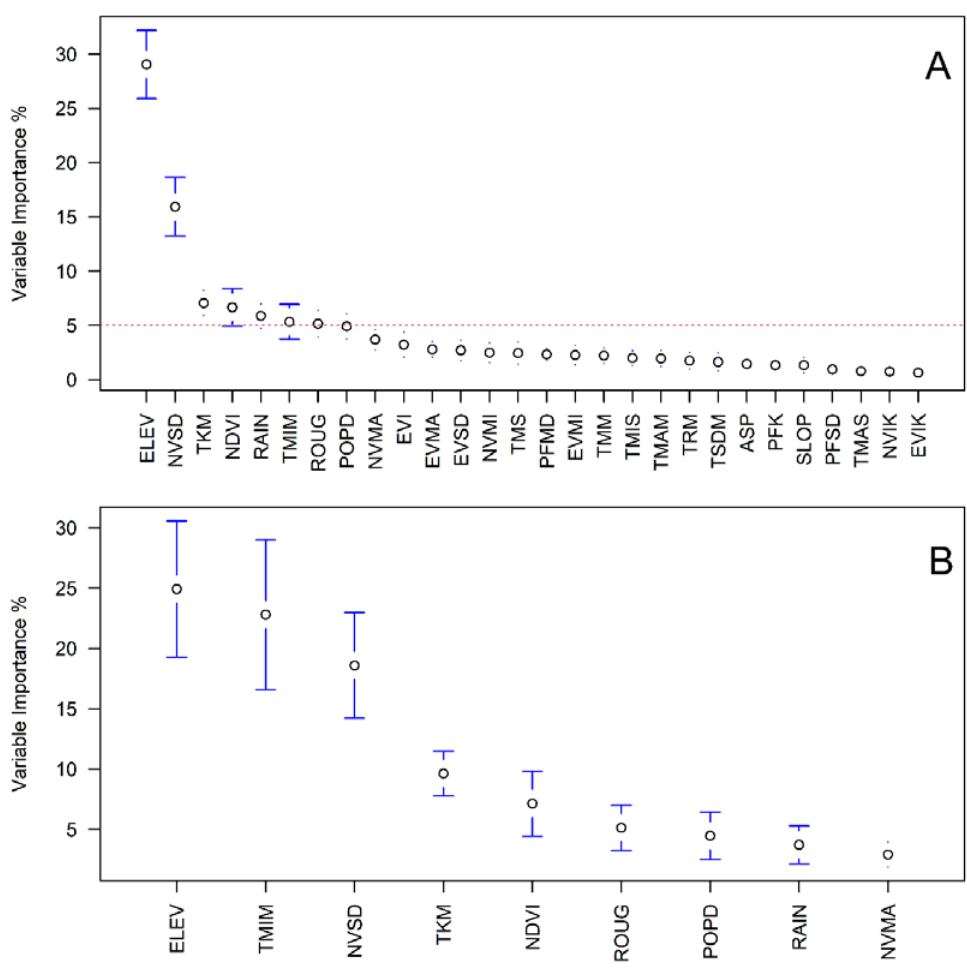
Figure 5. Variable importance in species distribution models of Anopheles albimanus ( A ) used for model selection (the dashed line indicates the 5% importance threshold) and ( B ) in the models used for the final ensemble prediction. Table 2. Mean area under curve (AUC) and true skill statistic (TSS) values, with standard deviation (±SD), based on the 10 model repetitions per algorithm that were used to build the ensemble distri- bution model for Anopheles albimanus in Costa Rica. Abbreviations: L-GLM, logistic generalized lin- ear model; MARS, multiple adaptive regression spline; CAT, classification and regression trees; RF, random forest; GBM, generalized boosting model; ANN, artificial neural networks; MAXENT, max- imum entropy.